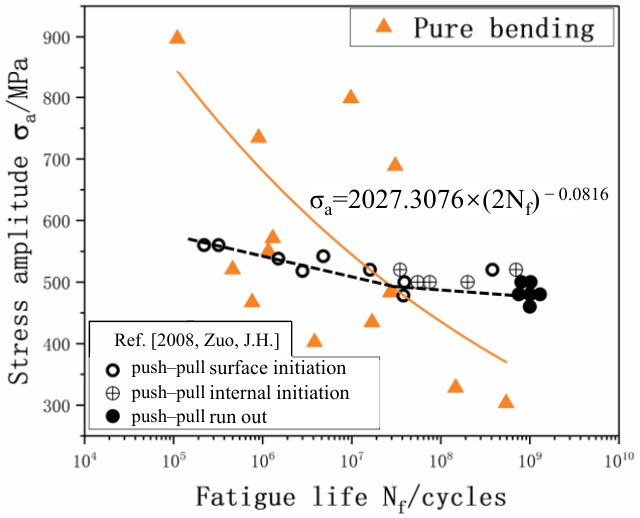
Figure 8. S-N curves of ultrasonic bending fatigue in comparison to the axial fatigue in literature.